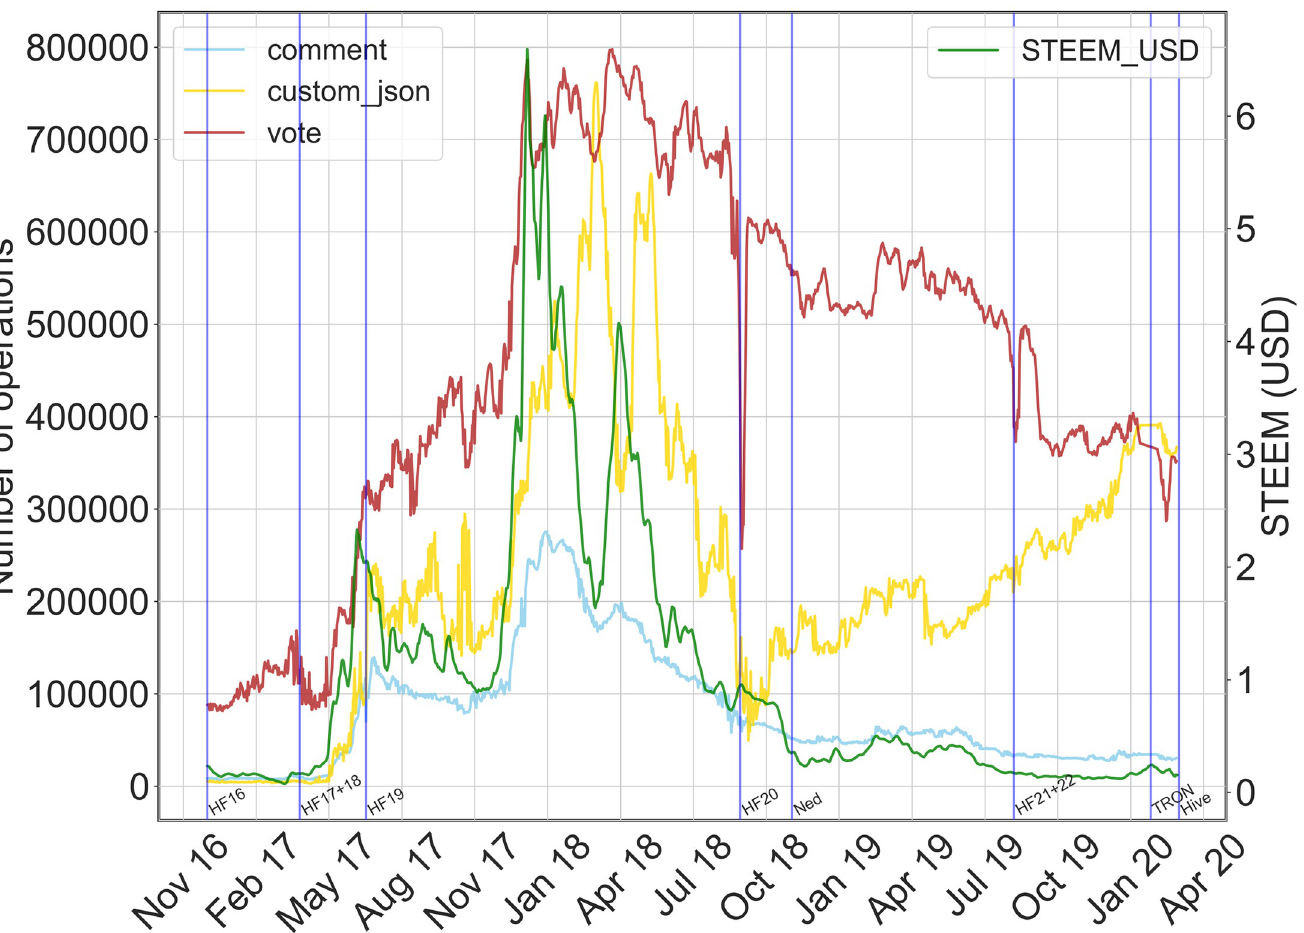
Fig 5. Daily volume of social actions. Time plots for social operations ( vote , comment and custom_json ) and STEEM price value in USD (green). On the x- axis: time in days. On the left y-axis: volume of operations per day. On the right y-axis: STEEM price in USD. The blue lines correspond to important events, like hard forks (HFXX), the crisis announcement by Scott (Ned), the selling of the company to TRON Foundation (TRON) and the Hive fork